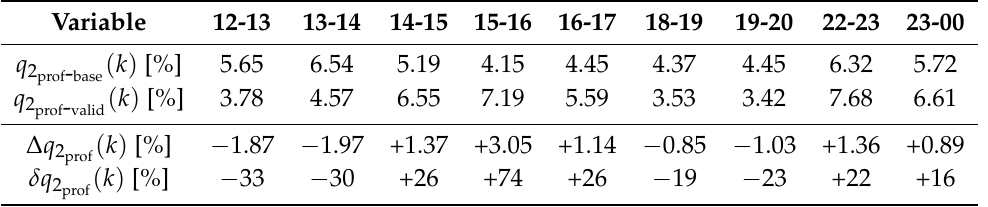
Table 4. Most notable differences between hourly demand